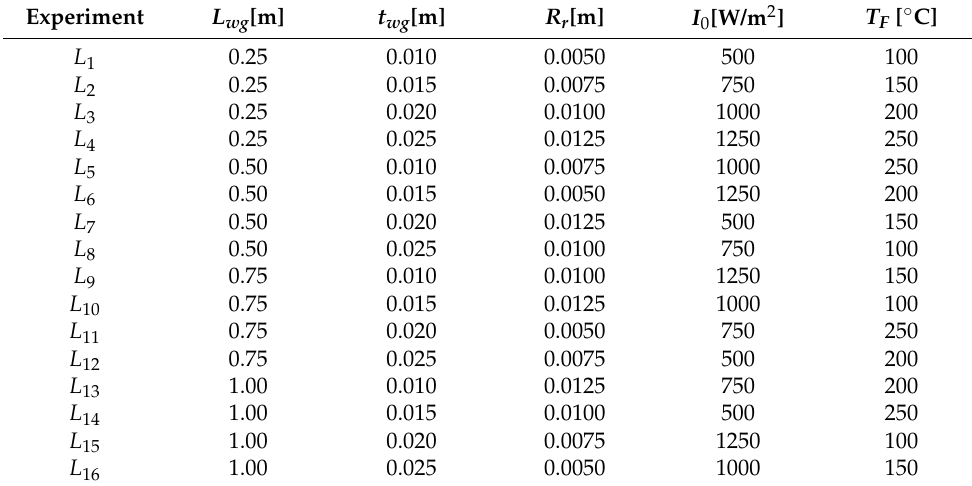
Table 2. L 16 Standard orthogonal